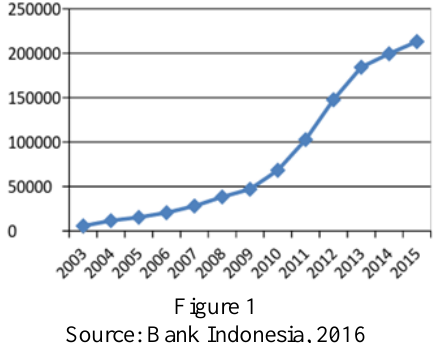
Figure 1 Source: Bank Indonesia,